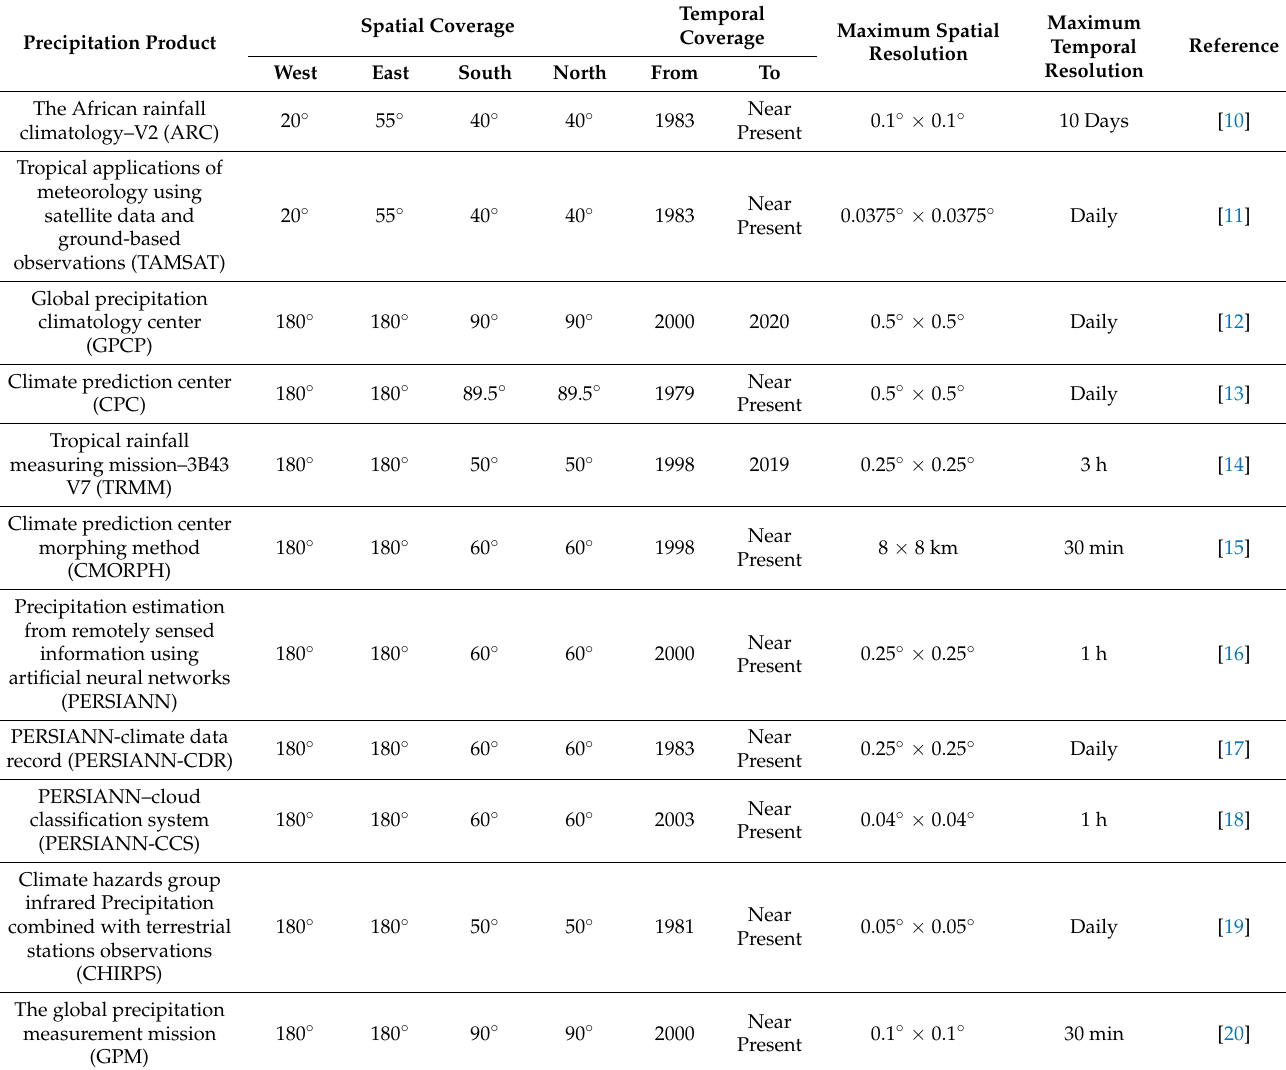
Table 1. Characteristics of some available precipitation